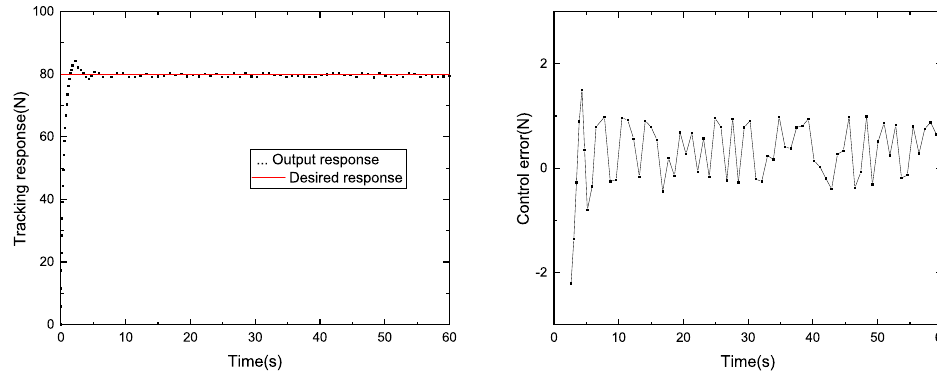
Figure 8. Tracking response and control error (SP-ADRC).